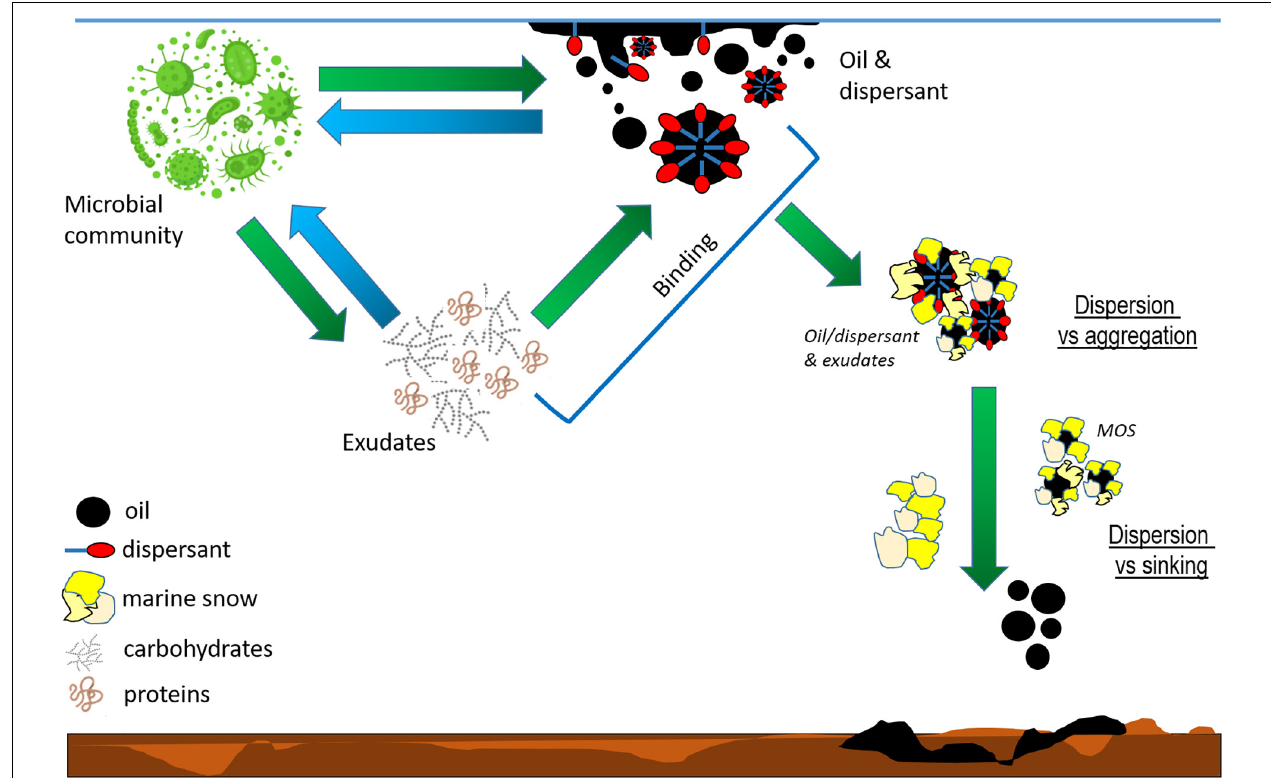
FIGURE 1 | Schematic of potential interactions between the microbial community and the oil or oil plus dispersant. Microbial exudates are released in response to the oil and dispersant, which then triggers a cascade of reactions. The binding between exudates and oil or oil plus dispersant impact the oil’s fate (dispersion versus aggregation), which in turn determines its distribution between the water column and sediments (dispersion versus sinking), degradation and grazing rates. The microbial community composition depends on oil and dispersant availability, which in turn determines the characteristics of microbial exudates and dictates the method microbes interact with the oil (direct or via